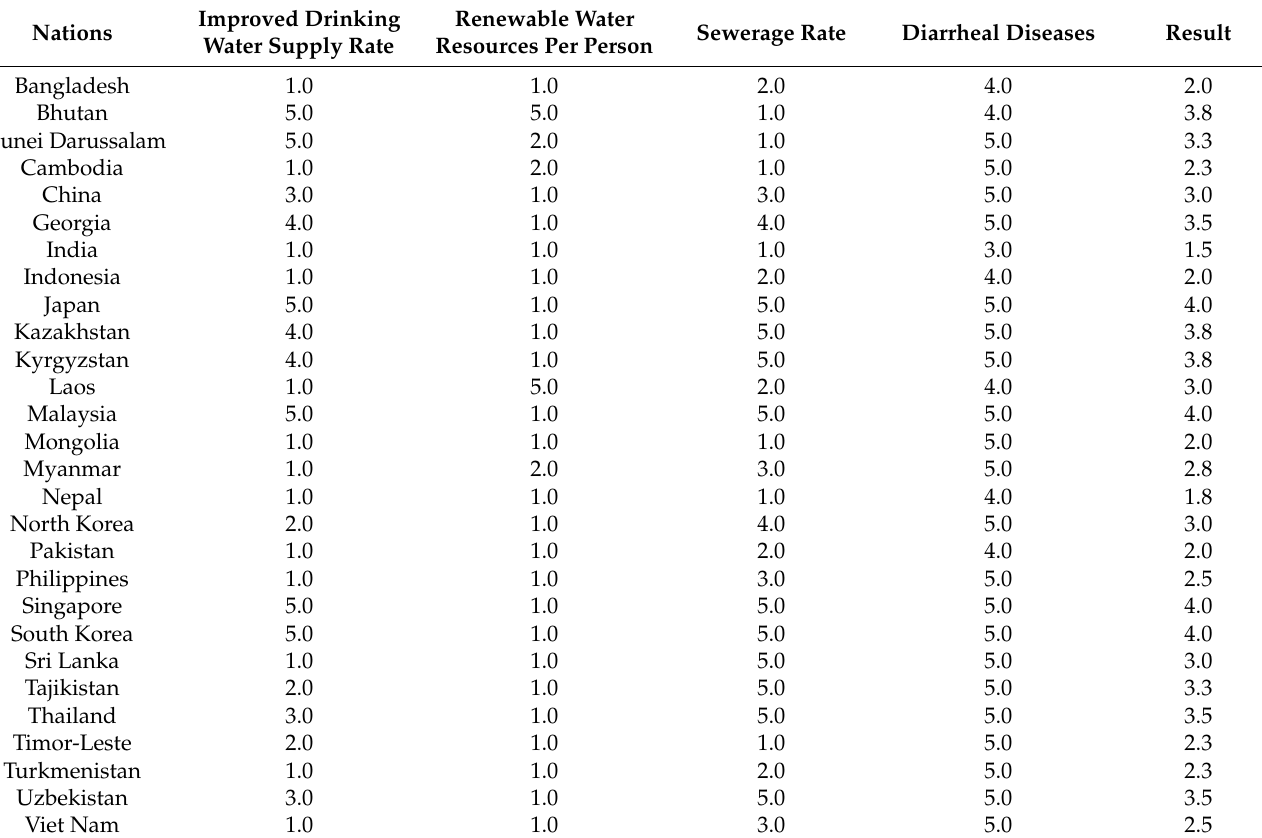
Table 7. Assessment results of social